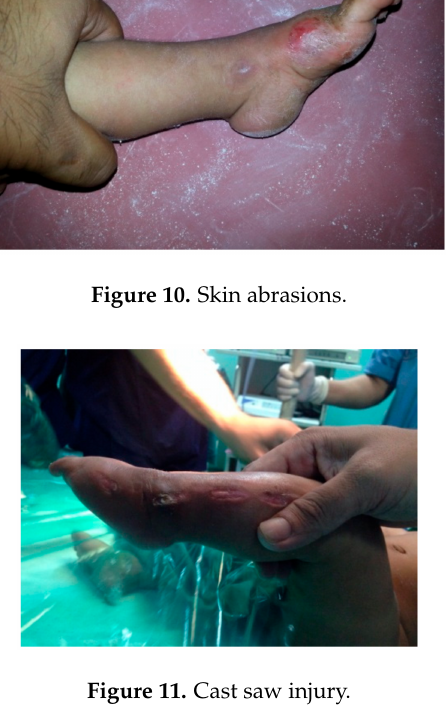
Figure 11. Cast saw